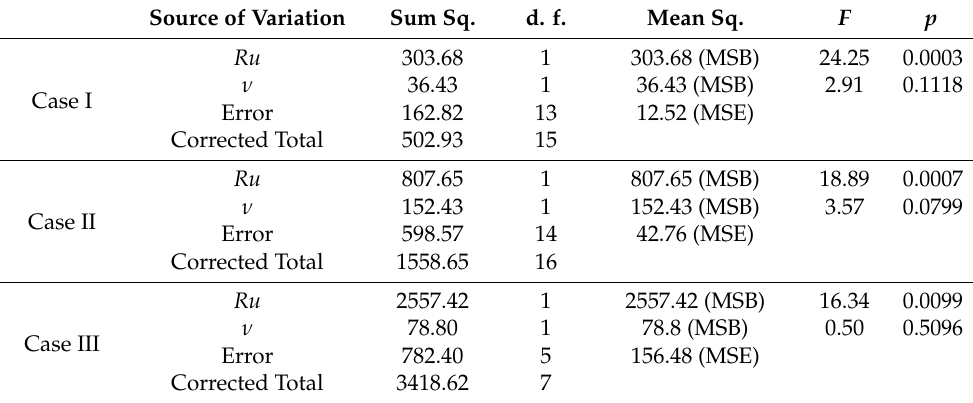
Figure 9. Two examples of comparison between the drifter-measured velocities ( x -axis) in the longshore direction and the theoretical velocities ( y -axis) based on Equation (5) by the given values of R and ν . Table 2. Dependency analysis of the bottom drag term, Ru , and the horizontal eddy viscosity coefficient, ν , to the relative reversal time by using the ANCOVA method. Each column of the table is explained as follows: (1) source of variation; (2) Sum Sq., the sum of the squares of the data; (3) d.f., the degree of freedom of the data; (4) Mean Sq., mean squares = (Sum Sq.)/(d.f.); (5) F , ANCOVA coefficient; (6) p , p